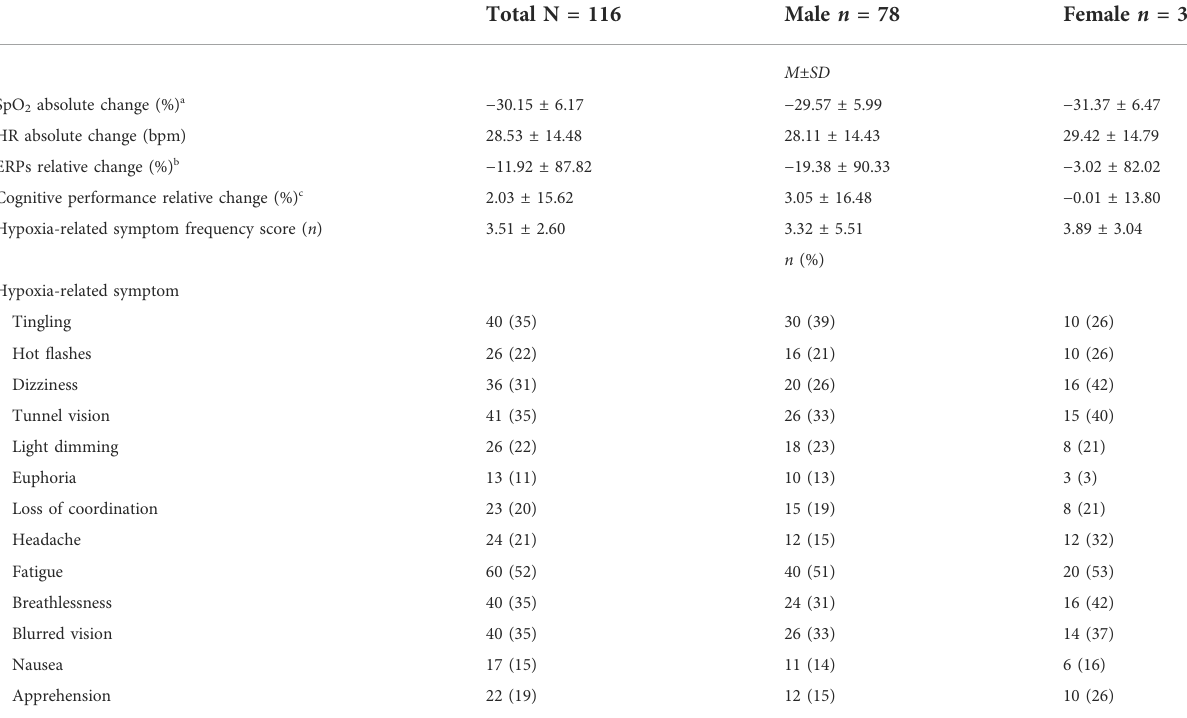
TABLE 2 Descriptive information of physiological, ERPs, cognitive performance, and self-reported hypoxia-related symptom outcomes by sex. Total N = 116